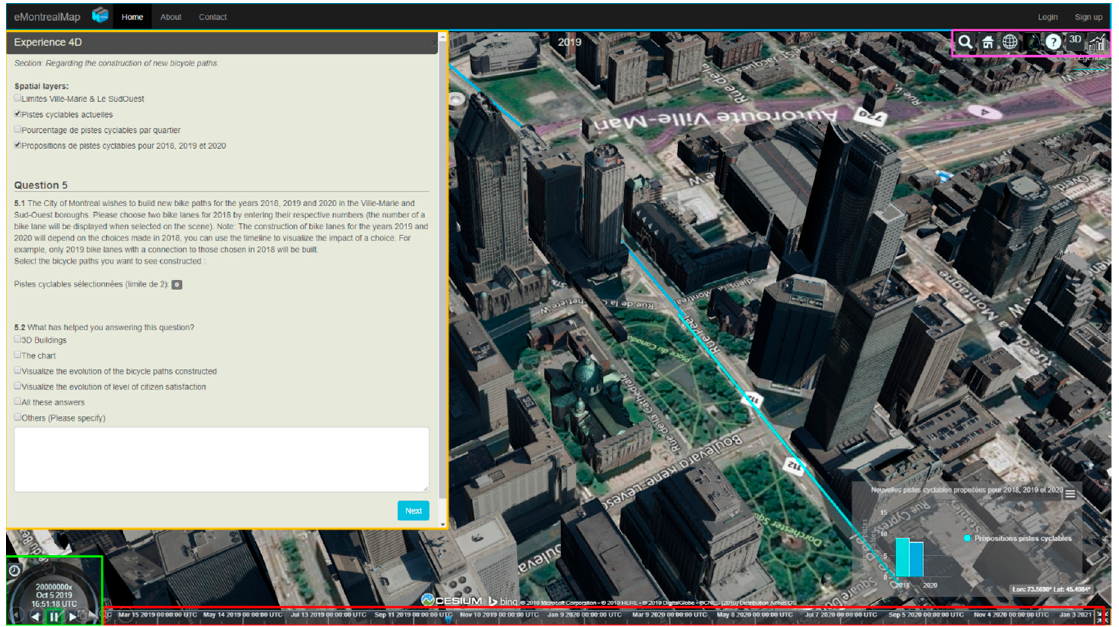
Figure 2. The questionnaire with the questions that users have to answer (here question #5) is on the left (orange box); the header of the interface is at the top (blue box), the toolbar (pink box); the bottom left clock (green box) and the timeline (red box) at the bottom of the screen; the scene in the midst occupies the majority of the platform.